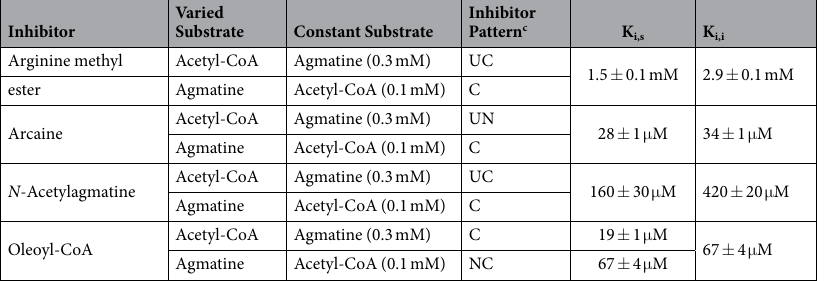
Table 4. Inhibitor Data for AgmNAT a,b . a Details for each set of inhibition experiments are provided in the legends to appropriate figures included in the supplementary figures. b Inhibition constants are reported as ± standard error. c C = Competitive inhibition, NC = noncompetitive inhibition, and UC = uncompetitive inhibition